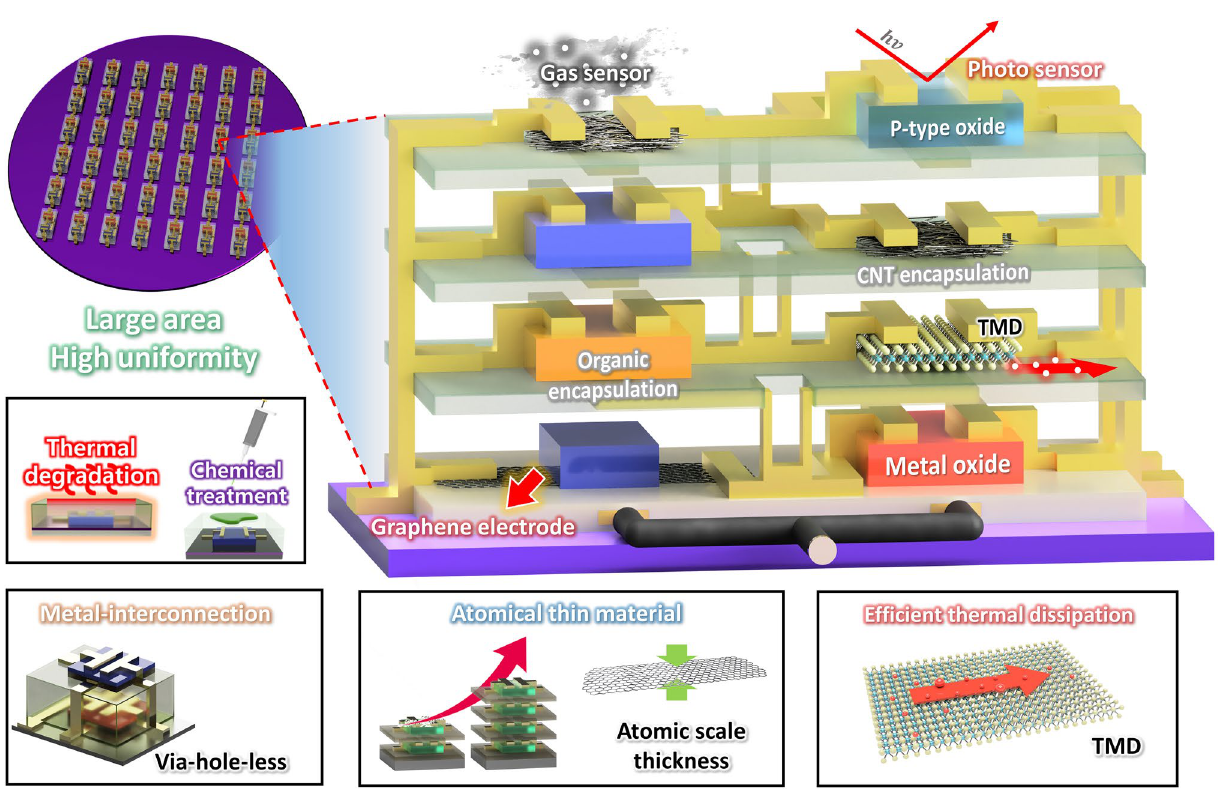
Fig. 12 An overview of 3D integration based on reliable metal interconnections and future applications of various semiconductor